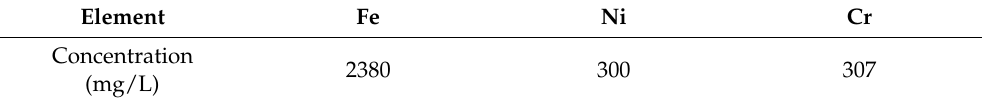
Table 2. The metal concentrations of stainless steel sludge after